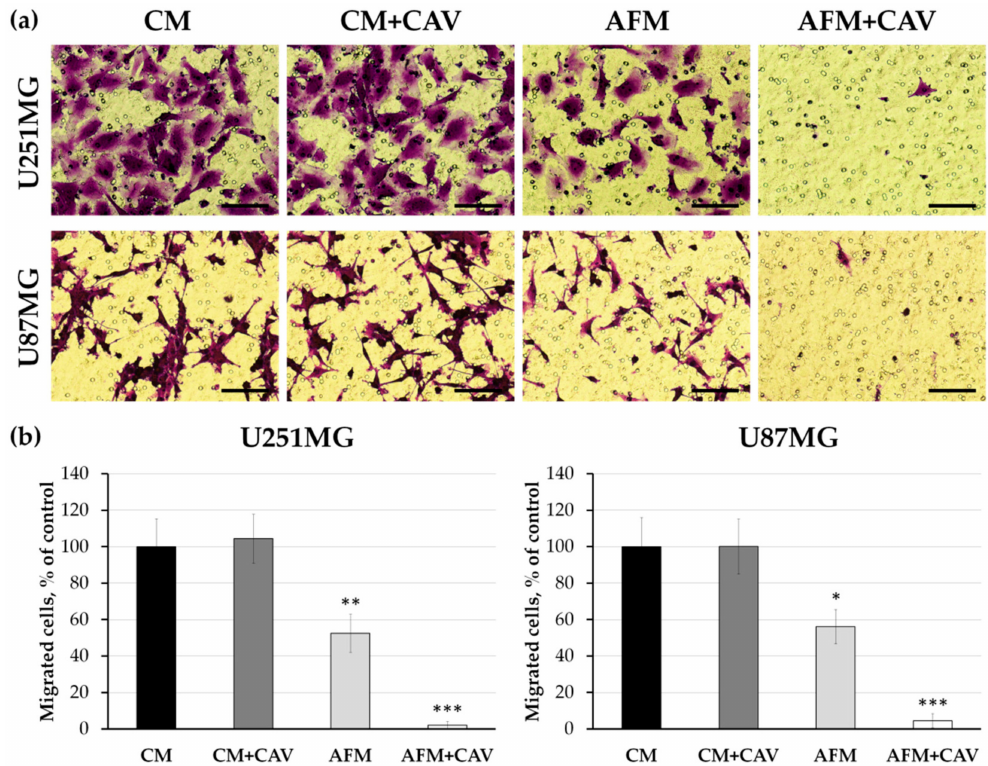
Figure 6. E ff ect of canavanine on human glioblastoma cell migration. ( a ) Representative images of migrated cells after the 48 h of co-treatment with 50 µ M canavanine under CM and AFM conditions. Bars, 100 µ m. ( b ) Quantification of migrated cells. Graphs represent mean values ± SD from three independent experiments. * p < 0.05, ** p < 0.01, *** p < 0.001 relative to CM (control,